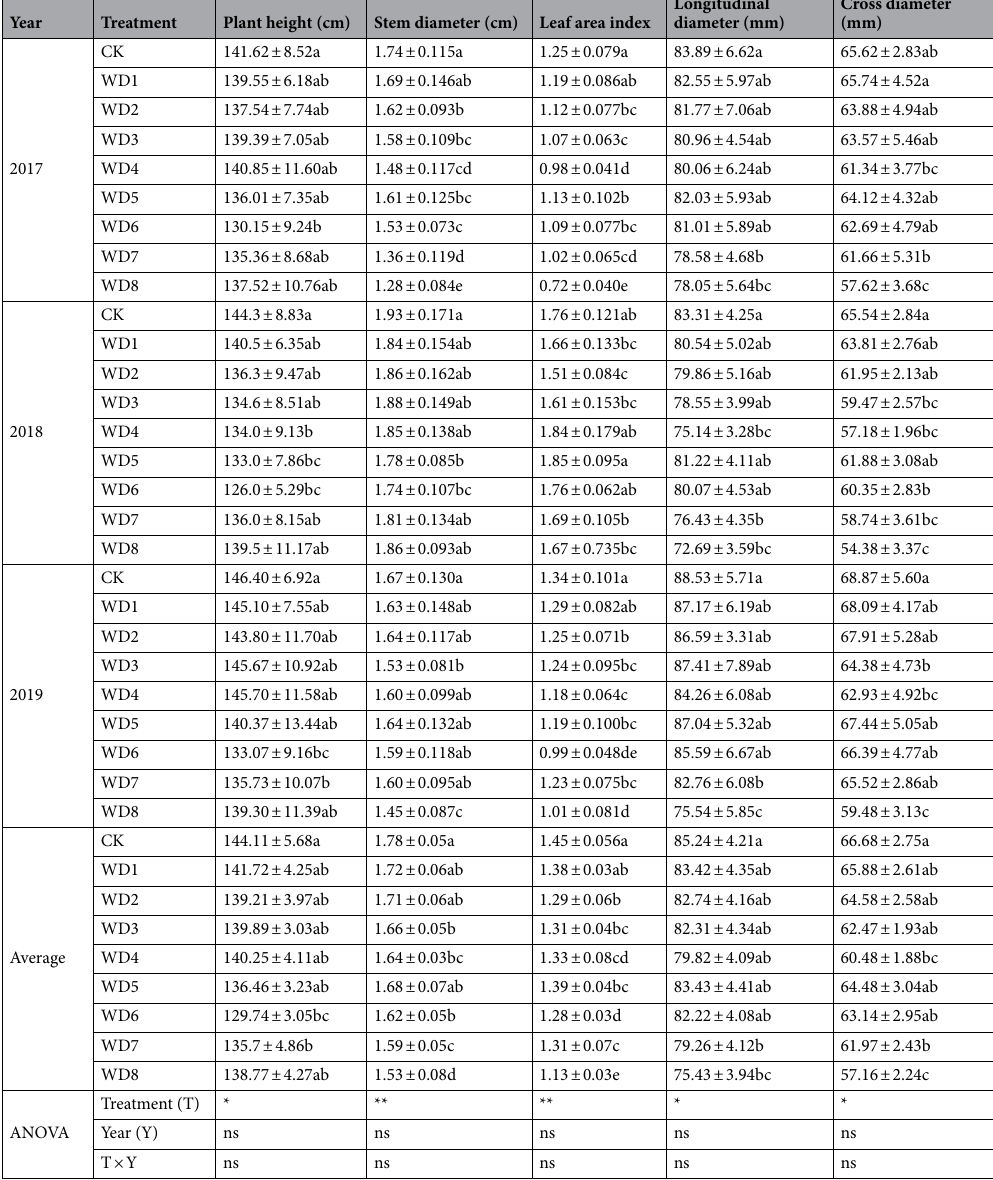
Table 1. Indices of potato growth in conventional irrigation (CK) and regulated deficit drip irrigation treatments in 3 years and averaged across years. Diameters are those of tubers. Different lowercase letters within a column for a year or the average indicate significant differences among treatments ( P < 0.05). The irrigation treatments were conventional irrigation (CK) and mild or moderate water deficit during each of four stages of potato growth. Mild deficit was in treatments WD1 (seedling), WD2 (tuber initiation), WD3 (tuber bulking), and WD4 (starch accumulation); moderate deficit was in treatments WD5 (seedling), WD6 (tuber initiation), WD7 (tuber bulking), and WD8 (starch accumulation). Values followed by the same lowercase letters within each year are not significantly different at the P < 0.05 level. *, **, and *** are significant at the P < 0.05, 0.01, and 0.001 levels, respectively. ns not